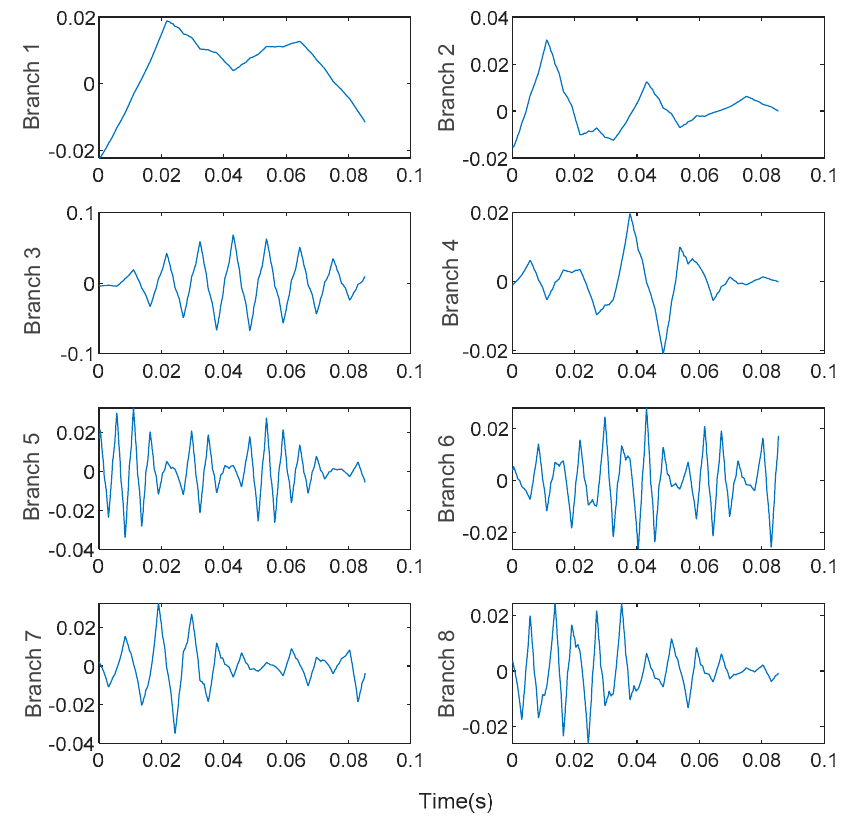
Figure 9. WPT decomposition branch signal of normal bearing vibration signal.